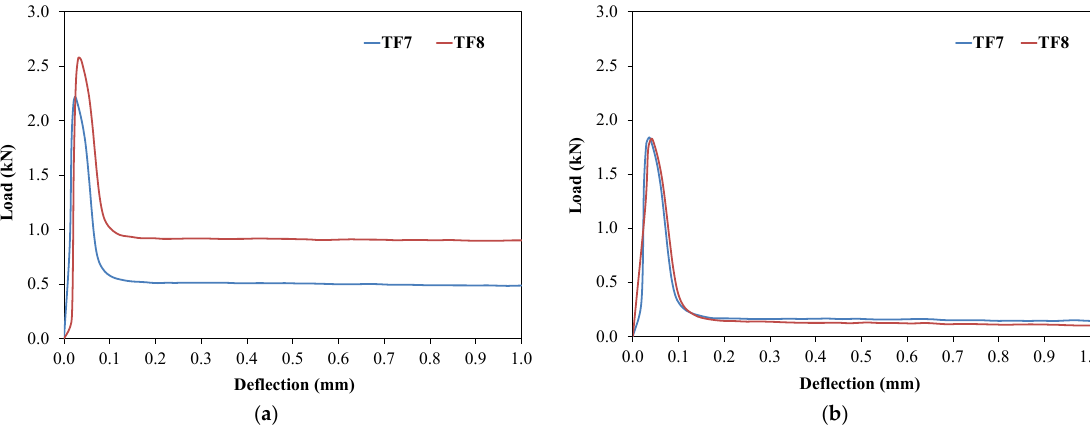
Figure 15. Load ‐ deflection behavior of twill (2/1) weave fabric ( a ) warp ( b ) Weft.